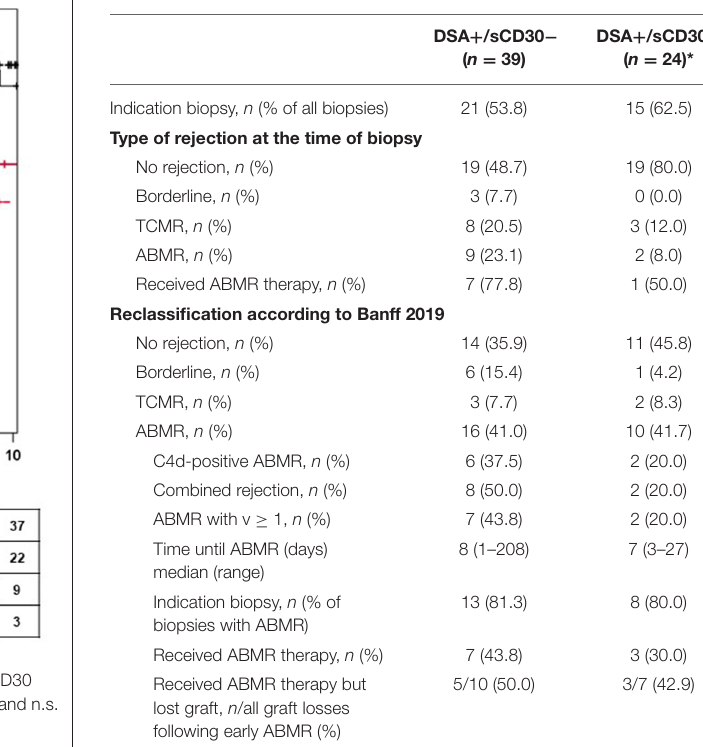
TABLE 2 | First year biopsy findings and treatment in DSA-positive